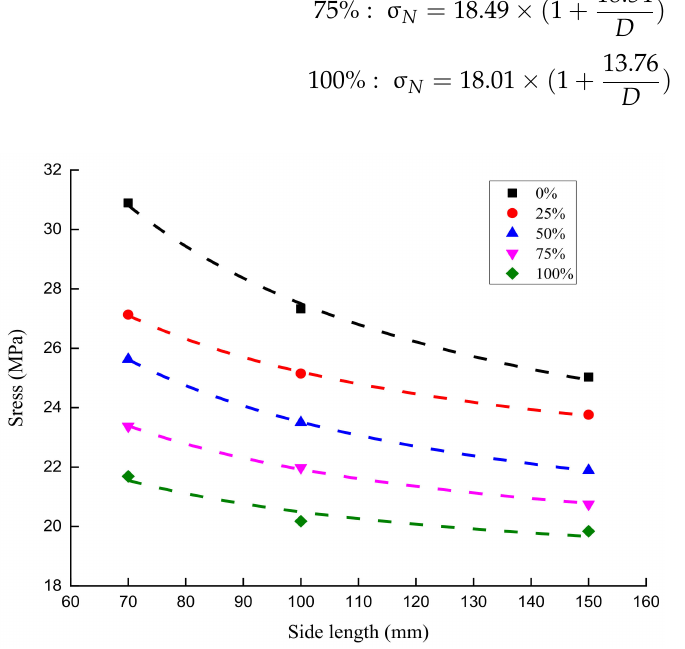
Figure 10. Mathematical regression curve of the size effect law of recycled aggregate concrete with different substitution ratios.